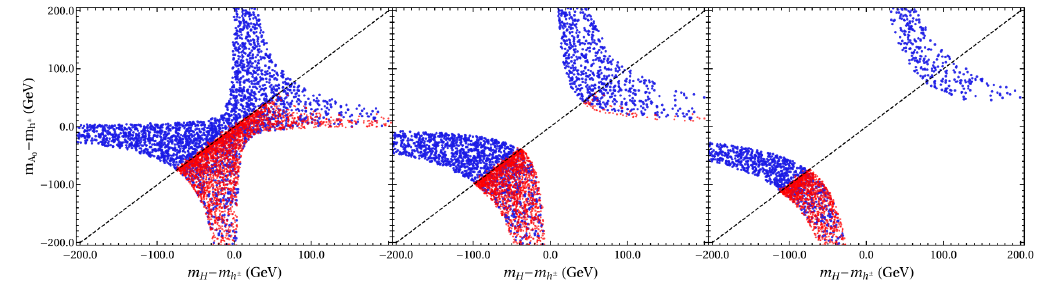
Figure 5 . Difference in mass among the neutral scalars H , A 0 and the charged scalar h ± complying at 95% C.L. with oblique parameters of equations (3.3), (3.4), (3.5) respectively. In blue we show the points in the 2HDM while in red the points of the 3-3-1